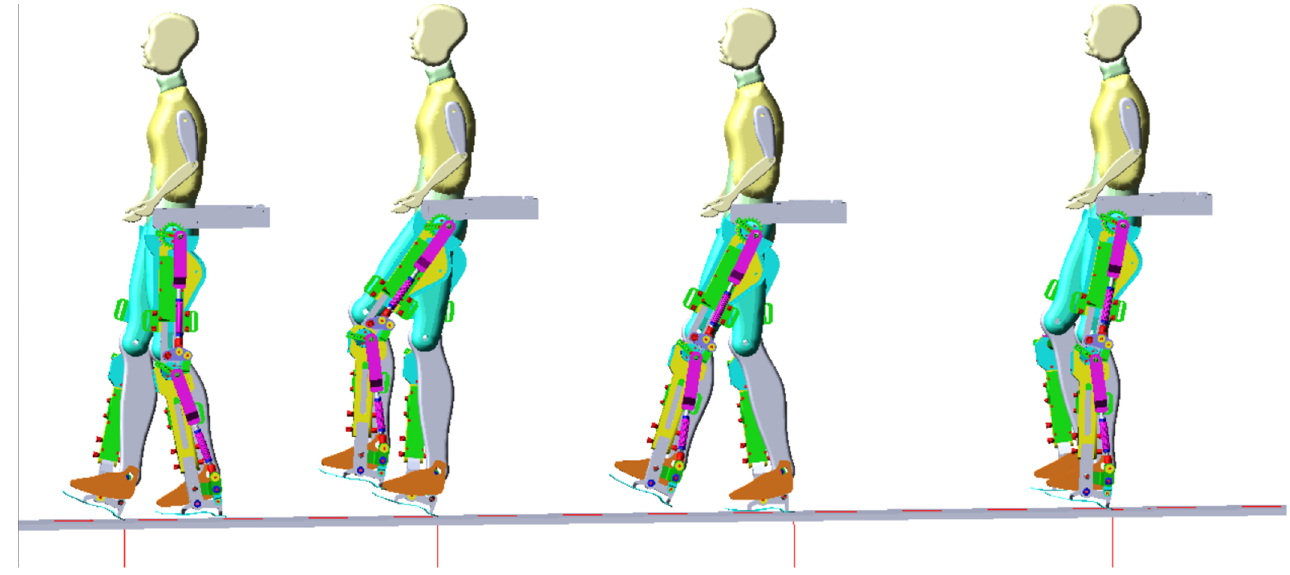
Figure 10. A snapshot during virtual simulations in dynamic mode for a complete gait.